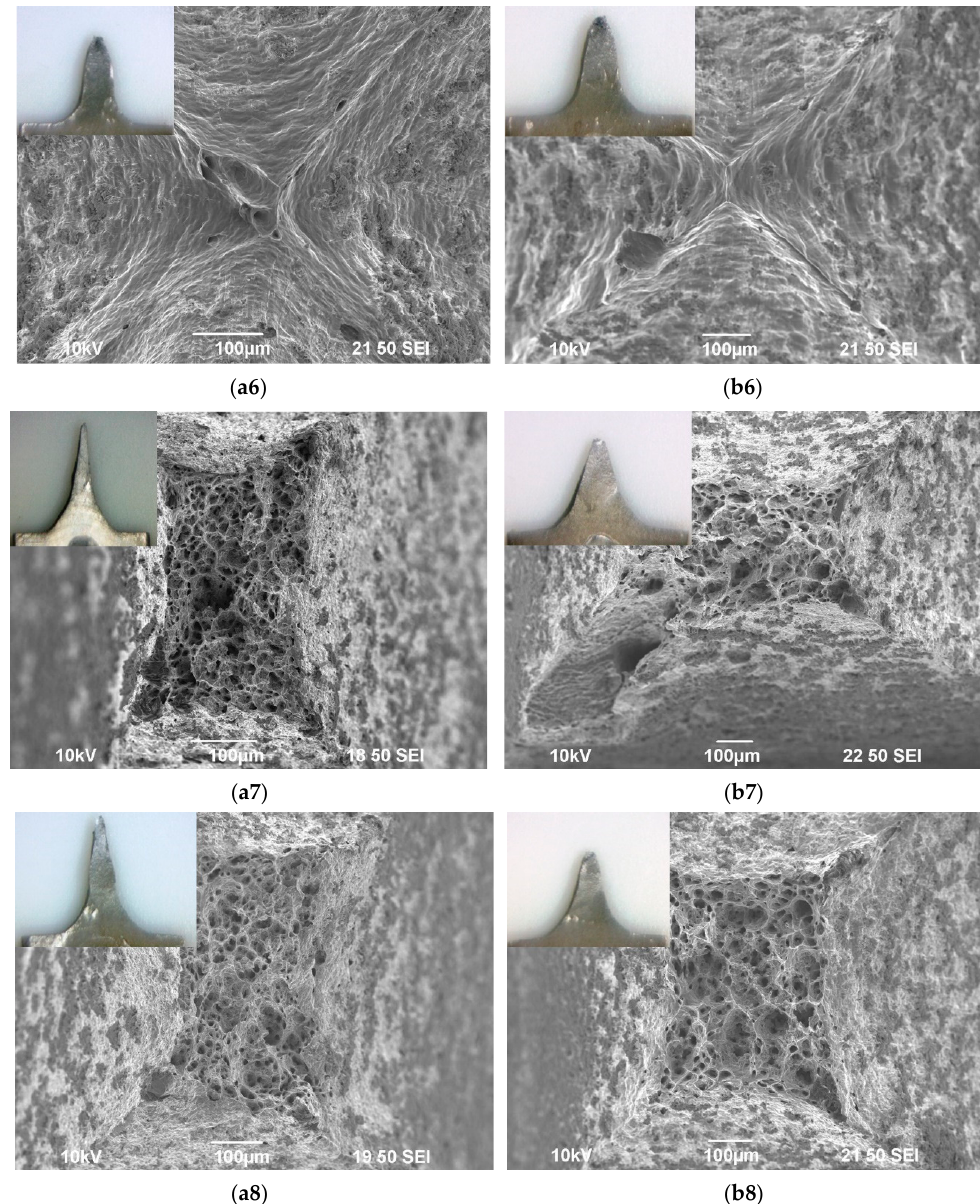
Figure A3. General view of fractures in UFG alloy specimens No. 1 ( a1 , b1 ), 2 ( a2 , b2 ), 3 ( a3 , b3 ), 4